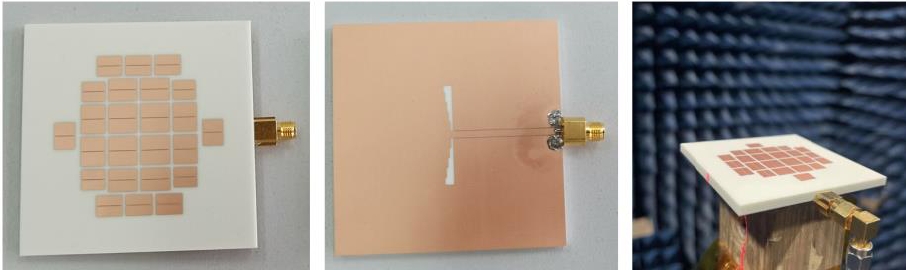
Figure 12. Photograph of the proposed antenna.